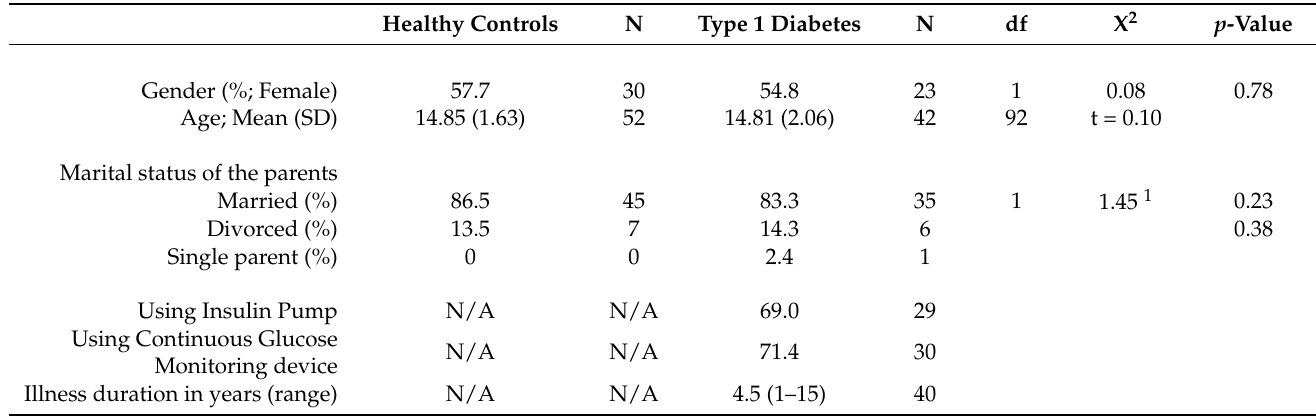
Figure 2. Study’s participants flow-diagram. Note: T1D: type-1 diabetes. Table 1. Descriptive statistics of sample